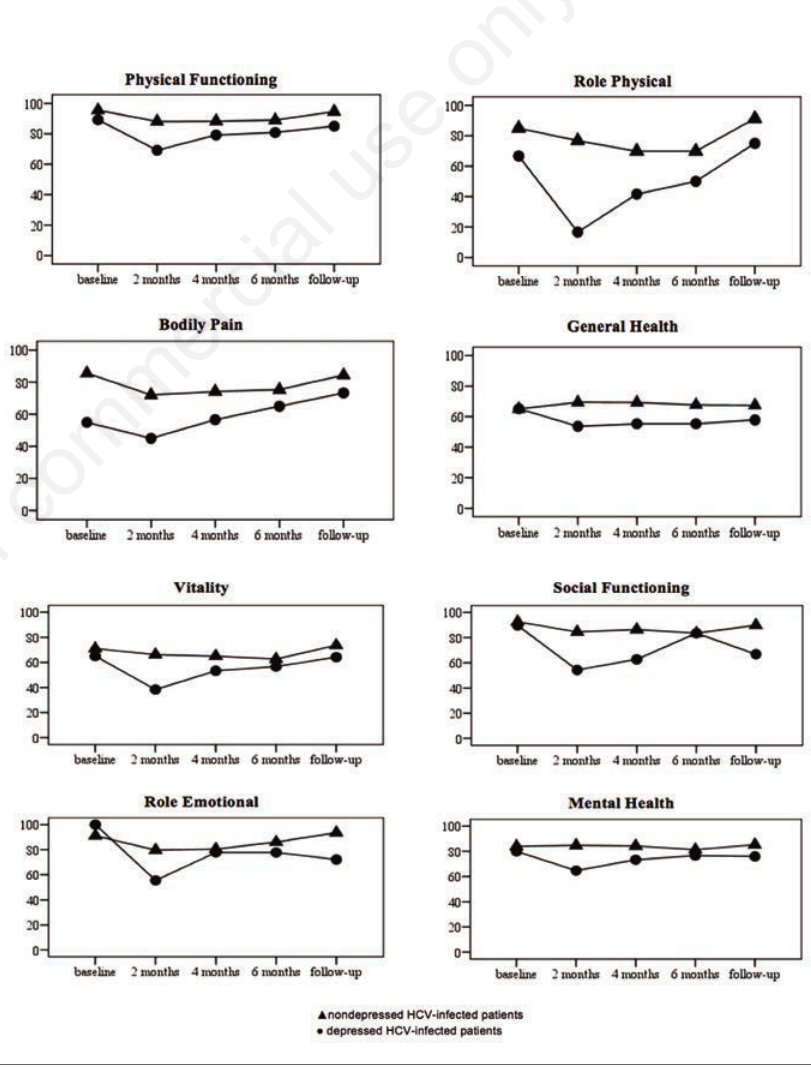
Figure 1. SF-36 scores in healthy norms (gray column) and patients with hepatitis C virus (black column).